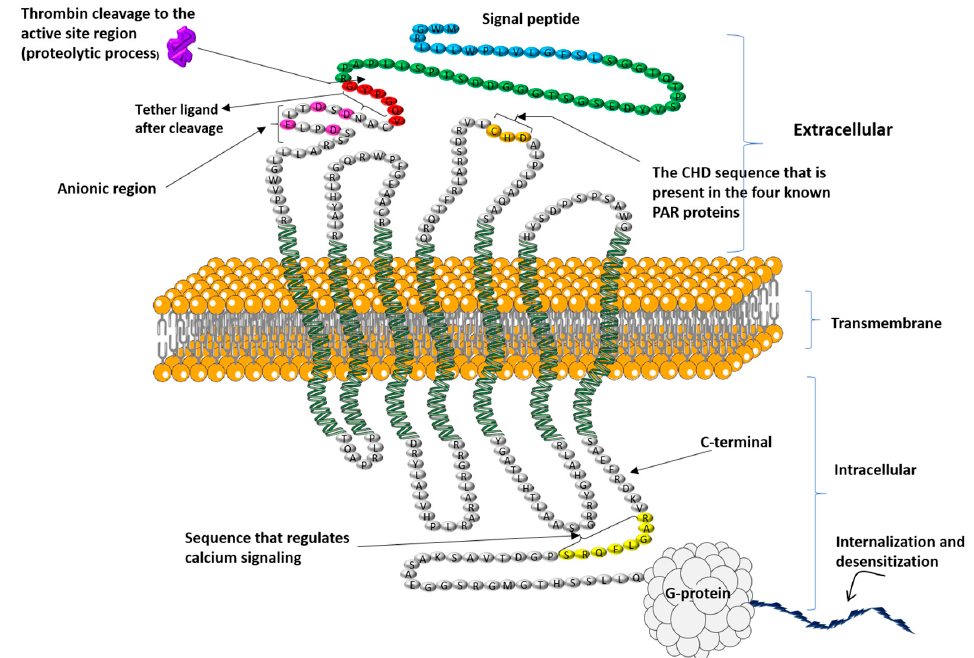
Figure 1. The proposed structure of human PAR4 with its different parts and their functions. Thrombin cleavage site that reveals a neo-amino-terminus (showed by arrow), the tethered ligand sequence that binds to the second intracellular loop after thrombin cleavage (sequence with the red color), and the Cysteine, Histidine, Aspartic Acid (CHD) amino acids sequence that is present in the four known PAR proteins (gold color), the RAGLFQRS sequence (showed by yellow color) discovered by Ramachandran and colleagues [17] for its role in regulating calcium signaling and interactions of the receptor with β -arrestins (1 and 2), and the anionic region that play a role of interacting with thrombin exosite-I (showed by rose color), and the signal peptide (showed by blue color), the amino-terminal peptide cleaved by thrombin (showed by green color), then the remaining extracellular and intracellular regions are shown in gray.